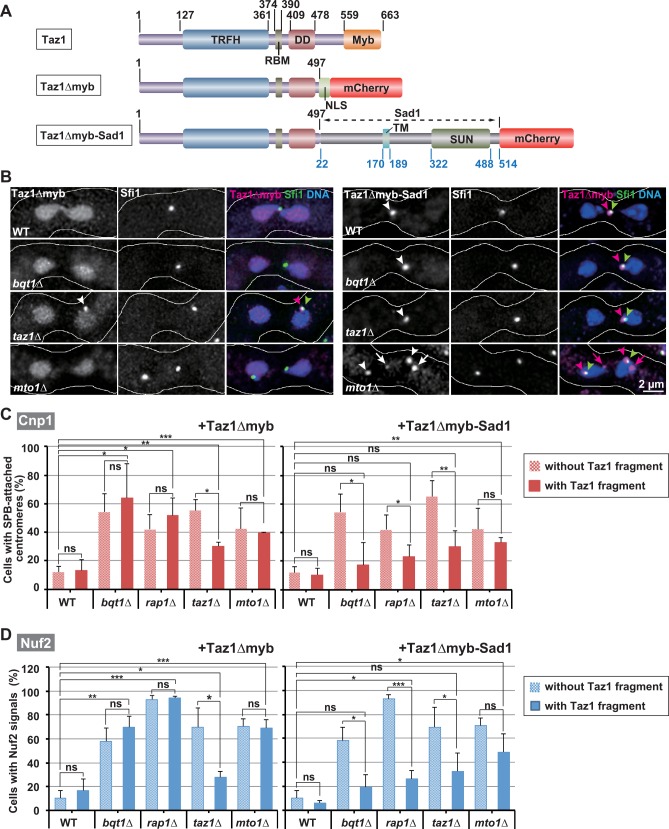
Effects of a Taz1 fragment on centromere positioning and kinetochore disassembly.(A) Schematic diagrams of Taz1, Taz1Δmyb, and Taz1Δmyb-Sad1. Black and blue numbers indicate amino acid numbers of Taz1 and Sad1, respectively. TRFH: TRF homology domain; RBM: Rap1-binding motif; DD: dimerization domain; Myb; Myb DNA-binding domain; NLS: nuclear localization sequence; TM: transmembrane domain; SUN: SUN domain [57] (http://www.pombase.org/spombe/result/SPBC12D12.01). Note that Sad1 lacks its N-terminal 21 amino acids. (B) Intracellular localization of Taz1Δmyb (left) and Taz1Δmyb-Sad1 (right) during karyogamy. Arrowheads show co-localization of SPB and Taz1Δmyb/Taz1Δmyb-Sad1 signals, and arrows show SPB-dissociated Taz1Δmyb-Sad1 signals. (C and D) Population of cells containing SPB-associated centromeres (C) or Nuf2 signals (D) during karyogamy. Averages of three independent experiments are shown. At least 30 cells were examined in each experiment. Error bars: standard deviation. Shaded bars indicate the data adopted from Figs 2D and 3C. Lines indicate sets of data that were statistically compared. *p<0.05, **p<0.005, ***p<0.0005; ns: no significant difference (p>0.05) (Student’s t-test). In all experiments, the fusion gene of Taz1Δmyb or Taz1Δmyb-Sad1 was integrated at the aur1+ locus on the chromosome and expressed under the taz1+ promoter.